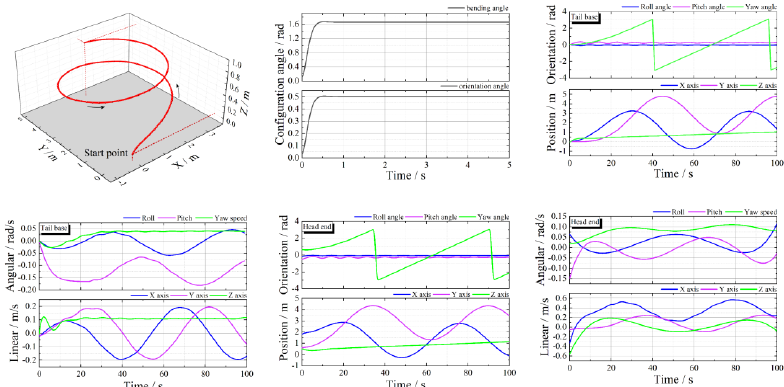
Figure 13. Simulation tests for spiral ascending motion under different conditions, which contain the trajectories, configurations of soft joints, position and orientation of robot base, linear and angular velocity of robot base, position and orientation of robot end, and linear and angular velocity of robot end.